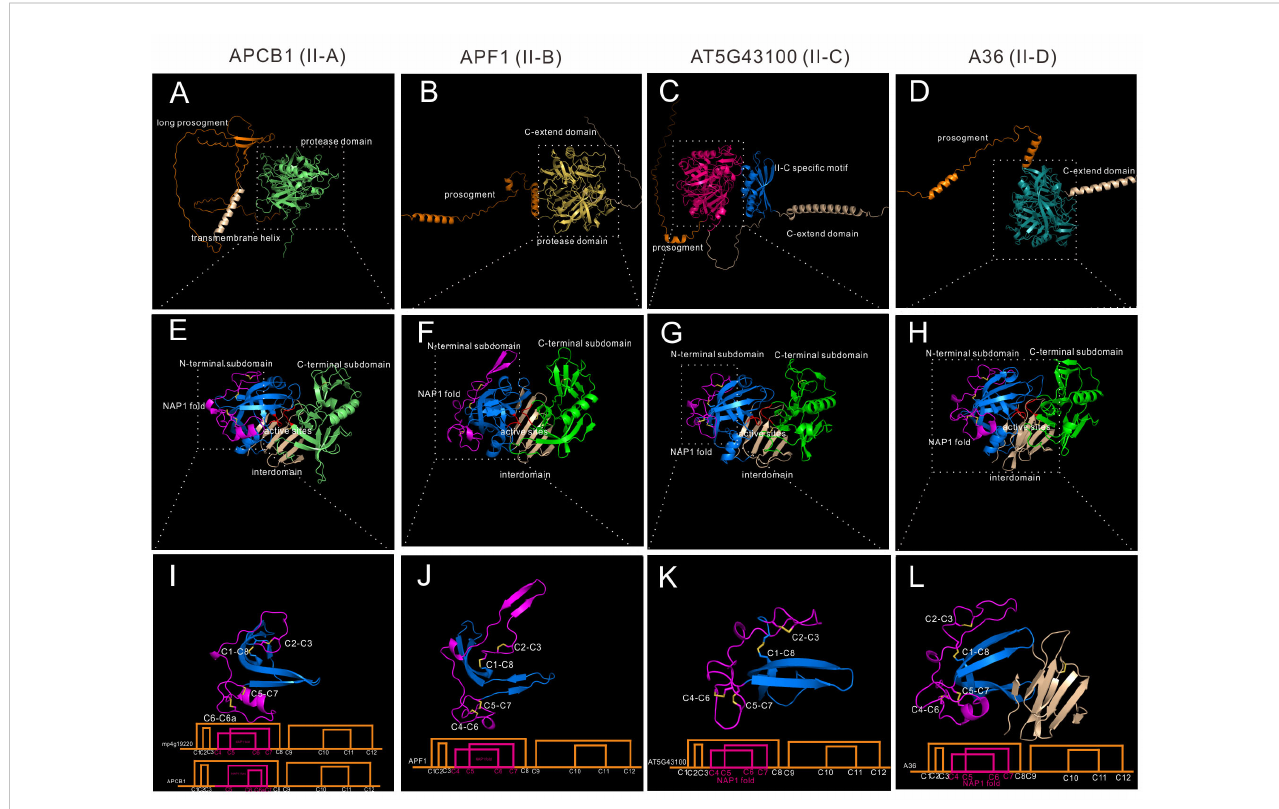
FIGURE 4 AlphaFold predicted structure models of group II (subgroup II-A to II-D). (A – D) Overall structures of APCB1, APF1, AT5G43100 and A36. (E – H) Protease domain of APCB1, APF1, AT5G43100 and A36. (I – L) NAP1 fold structure and disul fi de bond topology of APCB1, APF1, AT5G43100 and